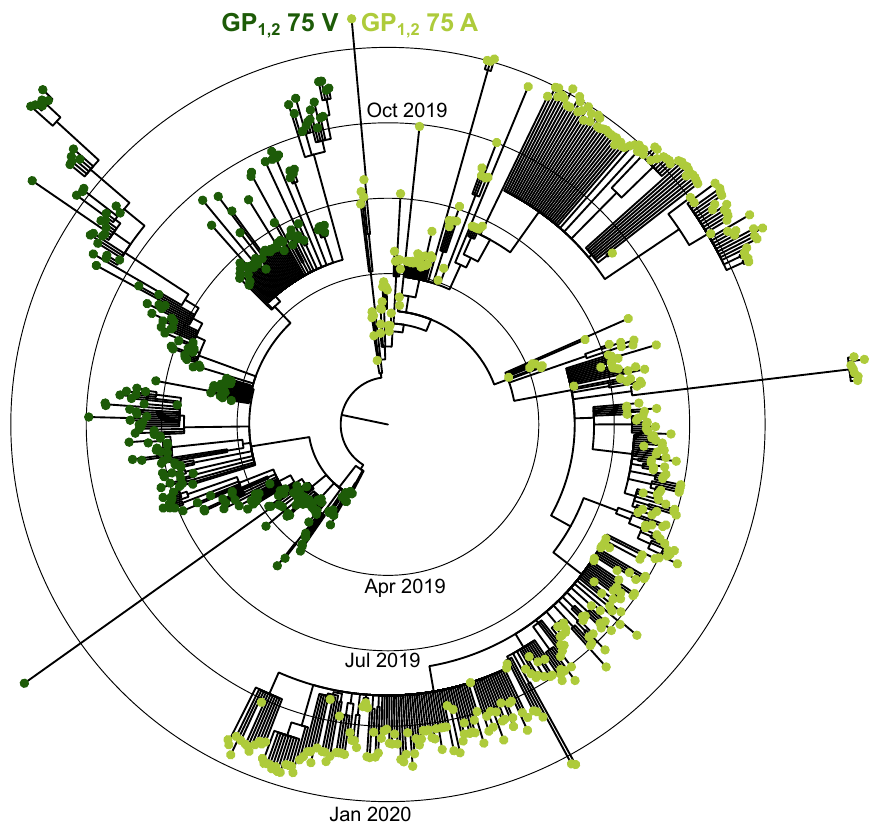
Figure 2. A time-scaled, maximum-likelihood inferred phylogenetic tree highlighting the valine- to-alanine change at glycoprotein (GP 1,2 ) position 75. The visualization is adapted from [48]. The estimated tree is comprised of 742 EBOV/Itu sequences. Tree branches are scaled to time. Taxon tips are colored by the presence or absence of the GP 1,2